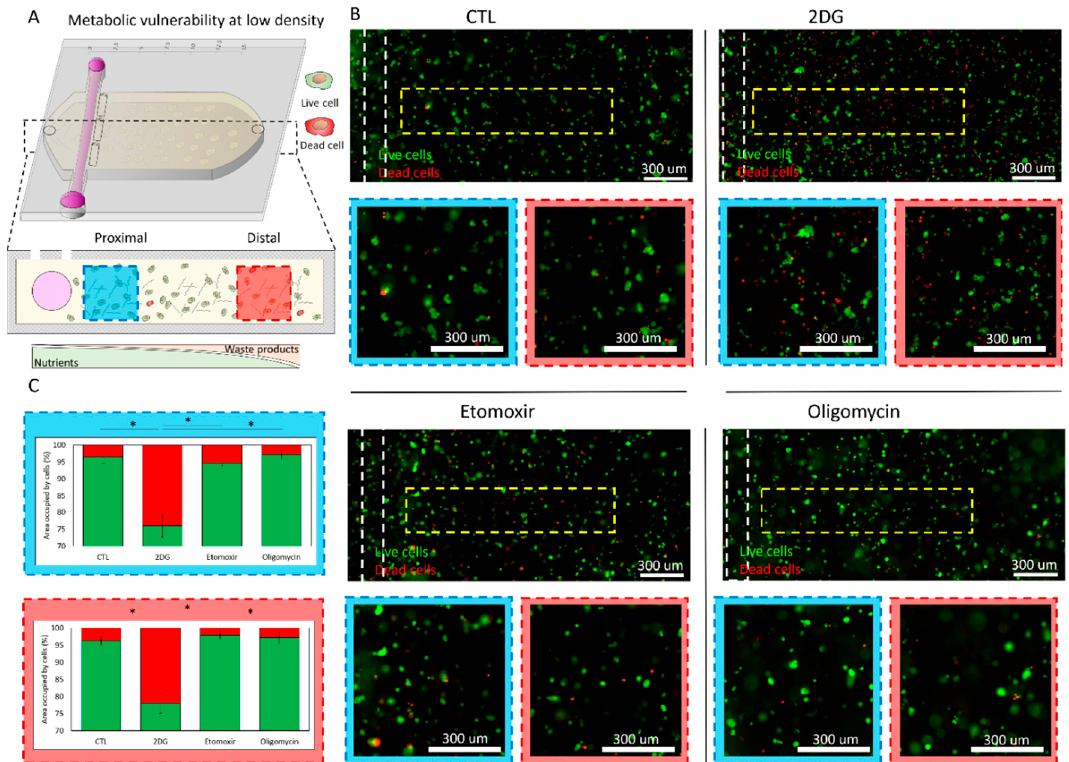
Figure 4. Metabolic vulnerability in low-density cell cultures. ( A ) Breast cancer MCF7 cells were cultured in the tumor-on-a-chip microdevice at 3 million cells/mL for 48 h in culture medium (CTL), 2-Deoxy-D-glucose (2DG), etomoxir, or oligomycin. Cell viability was evaluated using calcein acetoxymethyl (CAM) and propidium iodide (PI), labeling viable and dead cells in green and red, respectively. Cell metabolism was evaluated in the proximal (blue square) and distal (red square) area. ( B ) Fluorescence microscopy images showing cell viability across the collagen hydrogel at low magnification. Panels show cell viability in the proximal (blue square) and distal region (red square). ( C ) Bar graphs analyzing cell viability in the proximal (blue-dotted rectangle) and distal region (red-dotted rectangle) in the presence of 2DG, etomoxir, or oligomycin. Viable percent in green, dead cell percent in red. * denotes p -value < 0.05.